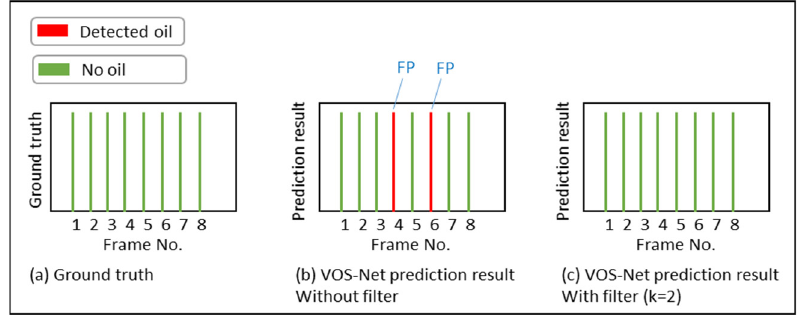
Figure 4. VOS-Net filter performance demonstration. Screening out single false-positive events improves the model accuracy to 99%.